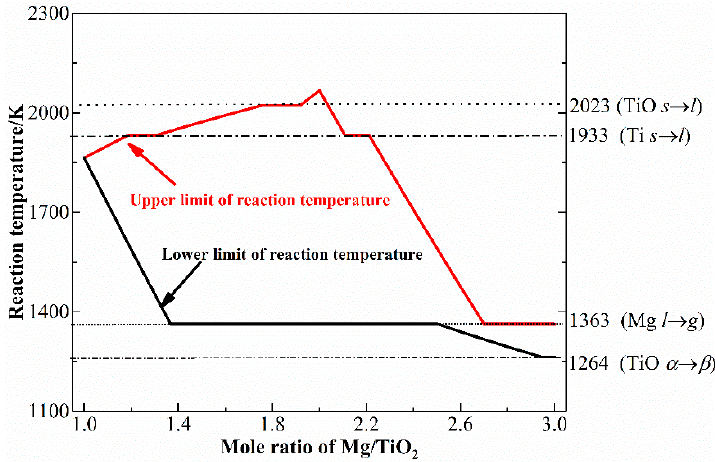
Figure 7. Actual combustion temperature range of the Mg-TiO 2 system (Initiation temperature 298 K).